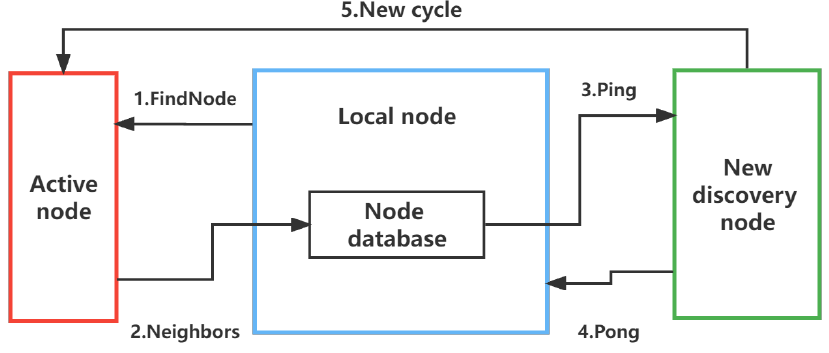
Figure 8. Sending and receiving processes of the node discovery protocol